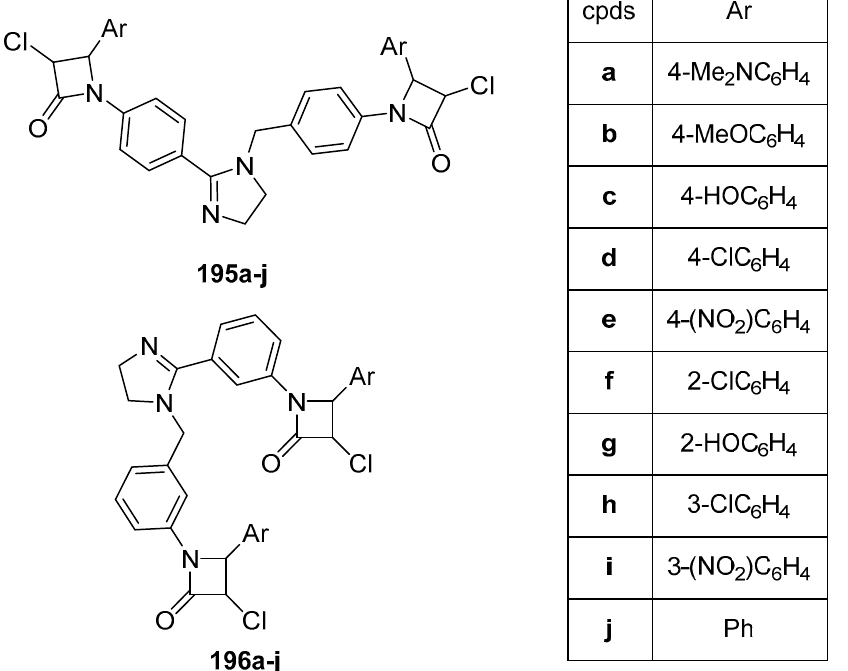
Figure 8. Structures of imidazole containing bisazetidinones 195 and 196.